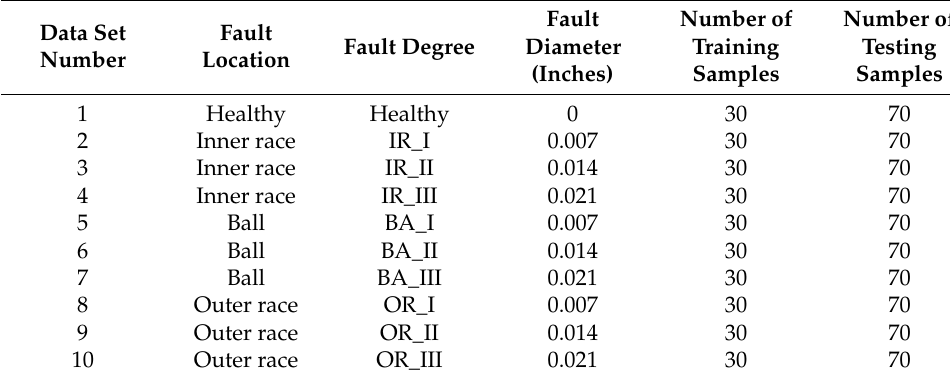
Table 1. Description of experimental data sets.